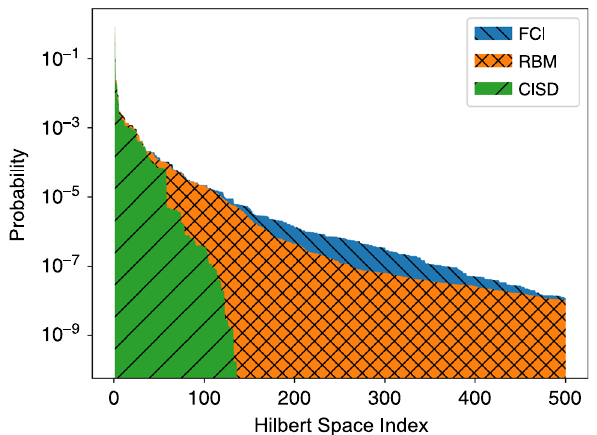
Fig. 2 Electronic correlations. Probabilities (in logarithmic scale) of the 500 most probable con fi gurations in the FCI (blue), RBM (orange), and CISD (green) wavefunctions for the equilibrium nitrogen N 2 molecule in the STO-3G basis.